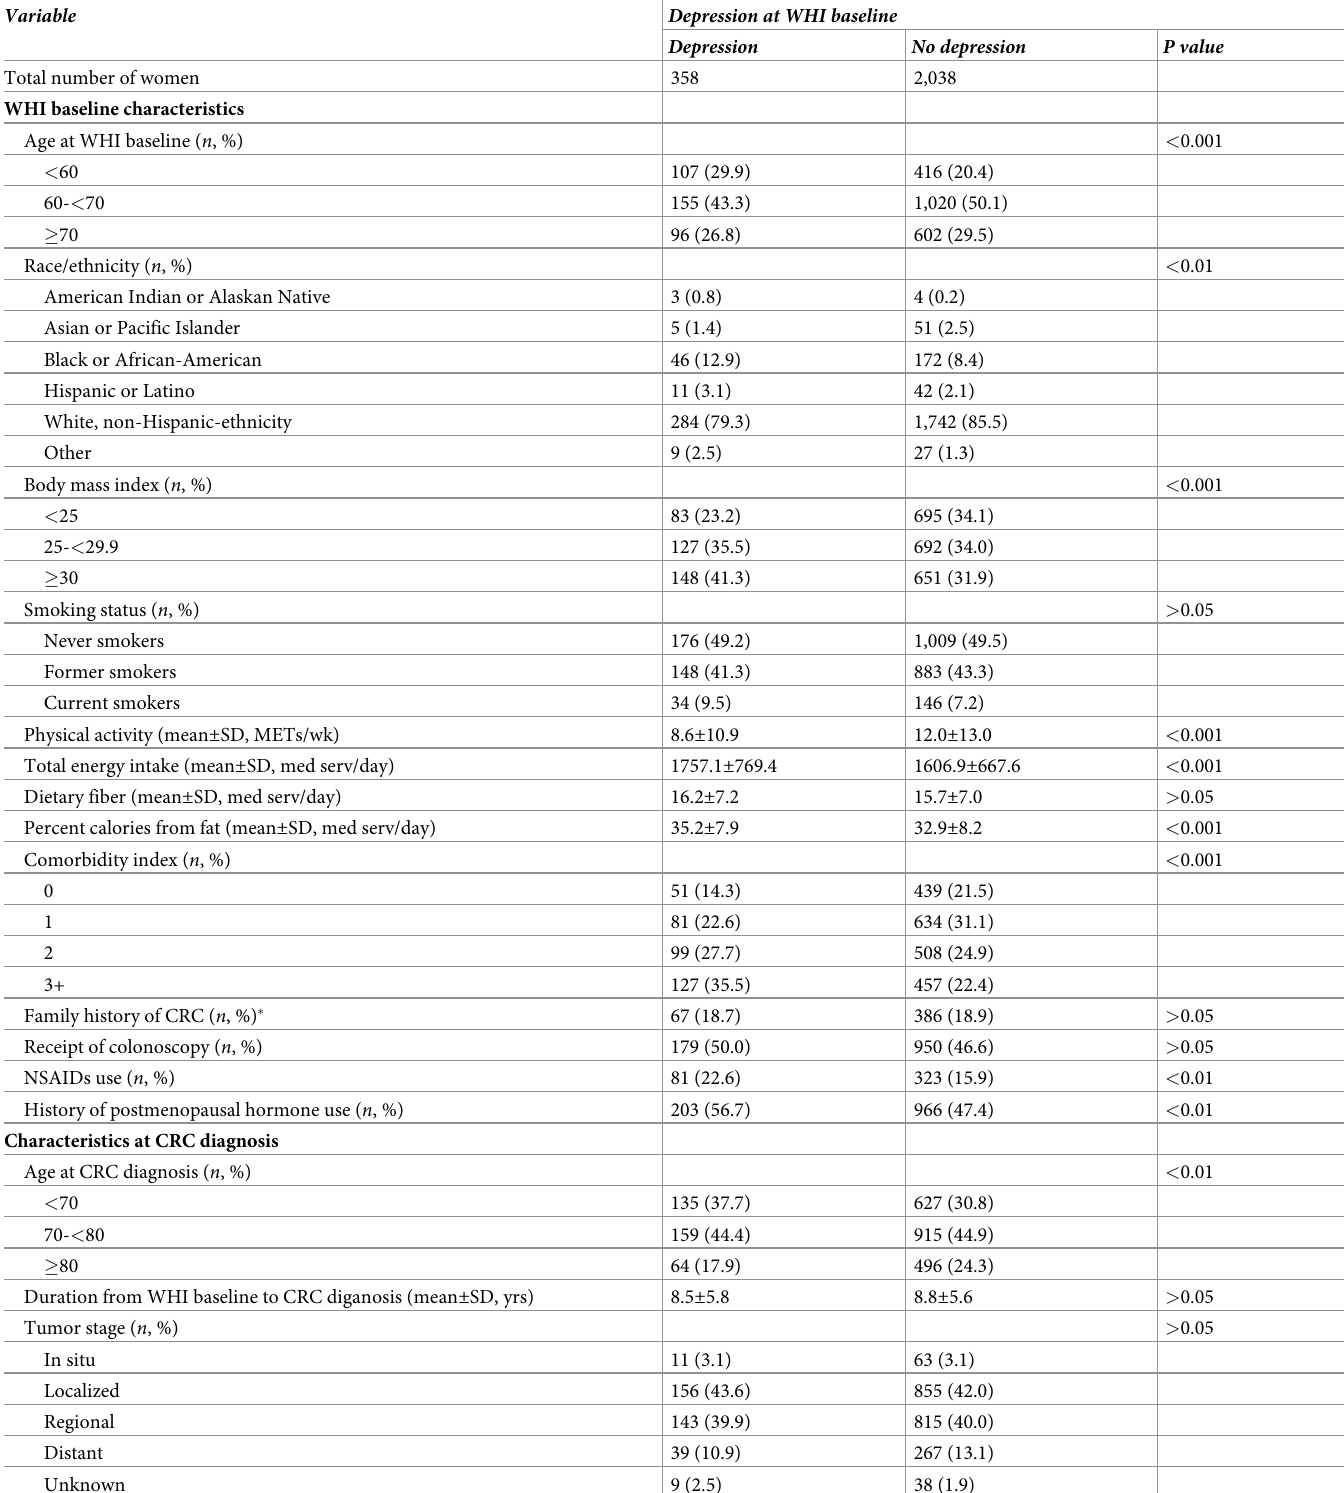
Table 1. Characteristics of participants by depression at WHI baseline ( n =